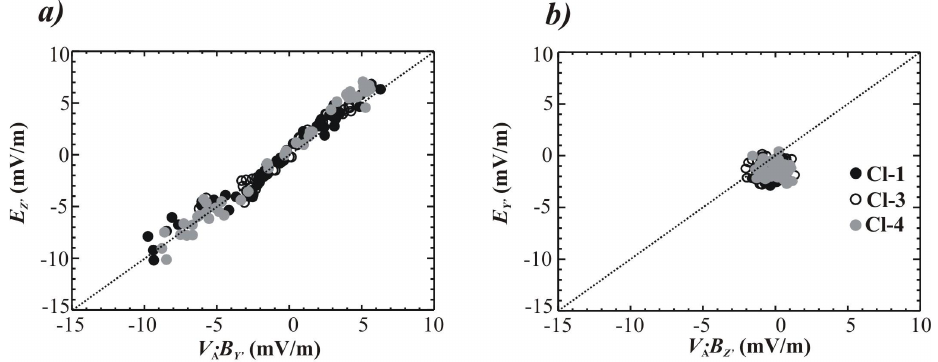
Fig. 6. Scatterplots of the values EZ 0 versus V A · BY 0 (a) and EY 0 versus V A · BZ 0 (b) obtained from the magnetic field and velocity of low-energy ions measured by three Cluster spacecraft between 08:21–08:24UT. Alfv´en velocity V A was calculated from the local plasma and magnetic field